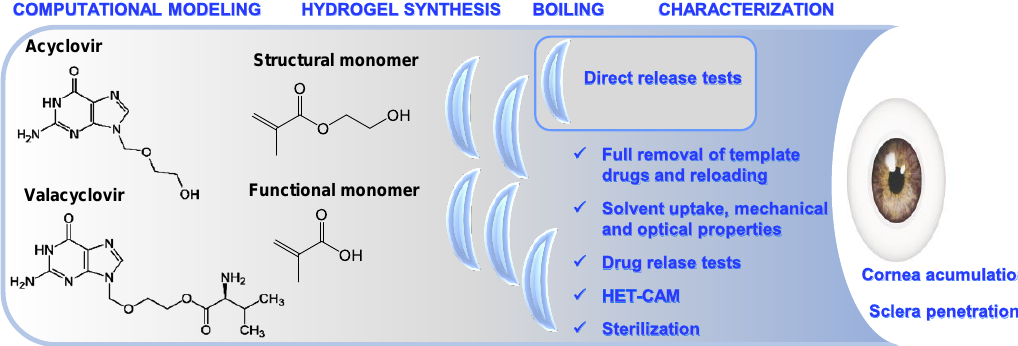
Figure 1. Structure of acyclovir (ACV) and valacyclovir (VACV) and workflow of the experiments.